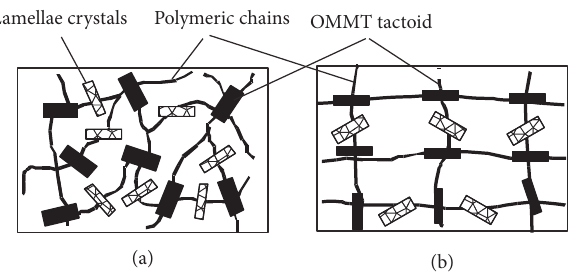
Figure 7: Schematic structures of the PP-OMMT composites after melt mixing (a) and ECMAE